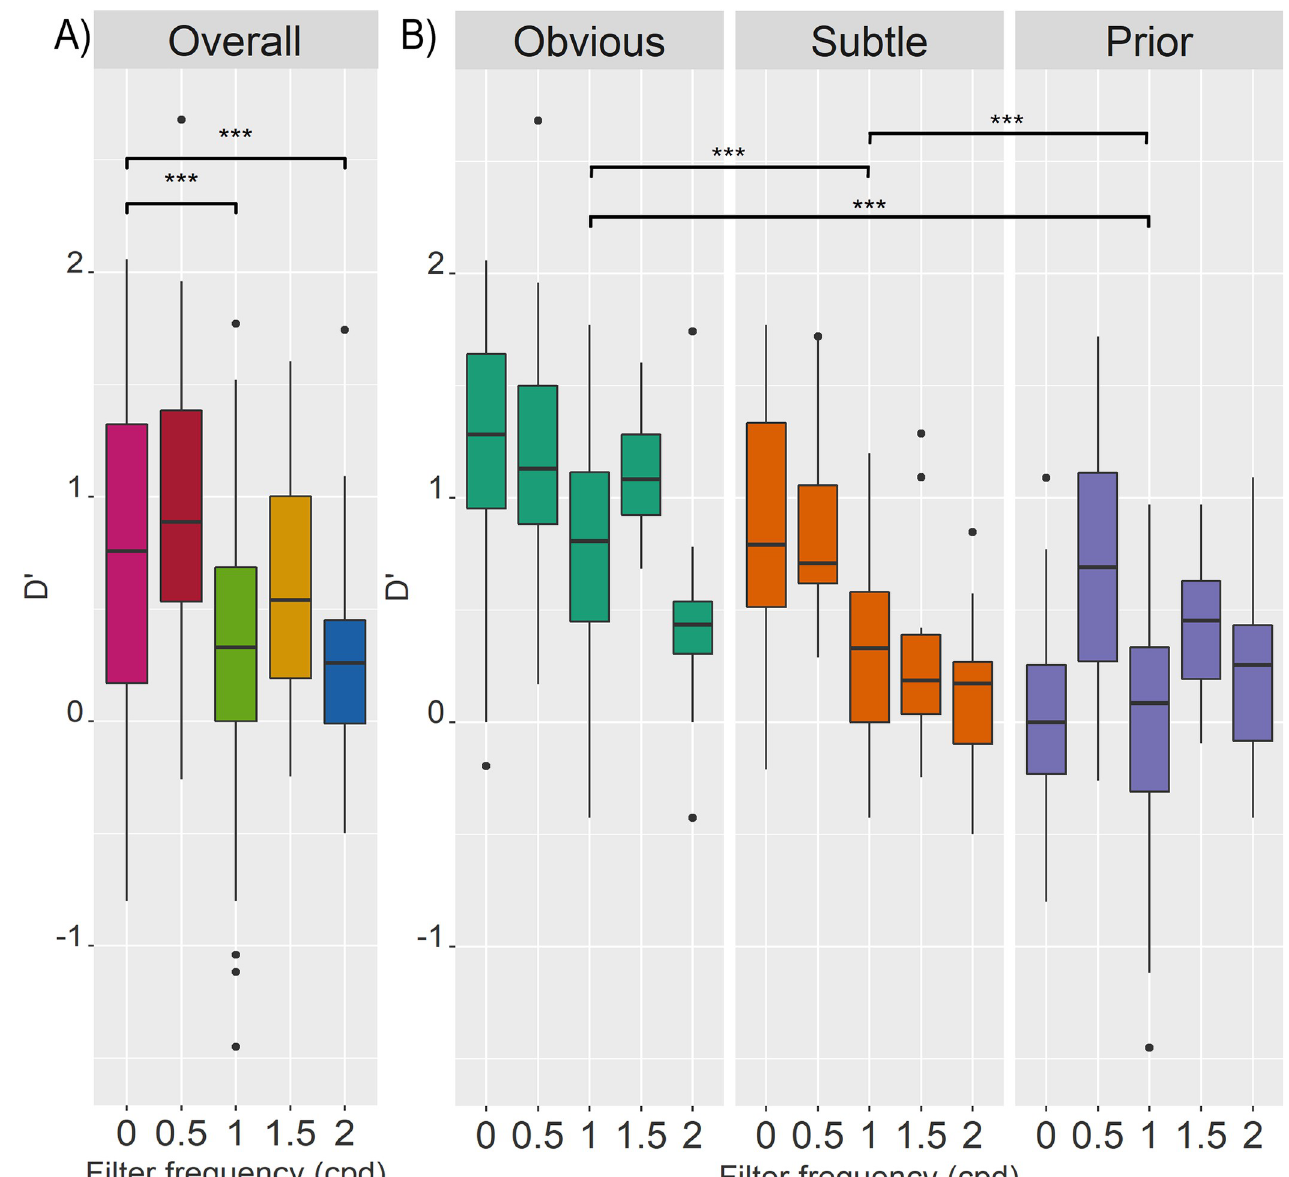
Fig 3. Boxplots of D’ across conditions. Each boxplot shows the median as the line within the coloured box containing the 25 th and 75 th percentiles, with extending whiskers containing the 95% CI, with any outliers plotted as dots. Significance of pairwise comparisons is indicated in the figure with � = p < .05, �� = p < .01, ��� = p < .001. (A) Boxplots showing D’ across frequency conditions (0, 0.5, 1, 1.5, and 2 cpd). Pairwise comparisons of frequency showed that D’ was significantly higher for F0 than F1 (estimated difference = 0.482, t(271) = 6.080, p = < .0001) and F2 (estimated difference = 0.397, t(282) = 4.502, p = < .0001), but did not differ significantly from F0.5 (estimated difference = -0.181, t(273) = -2.637, p = .067), and F1.5 (estimated difference = 0.007, t(282) = 0.083, p = 1.000)–and even trended towards a higher D’ in F0.5. (B) Boxplots showing D’ for each mammogram category (obvious, subtle, and prior) and frequency, to illustrate mammogram category and interaction effects. Pairwise comparisons of mammogram category showed that D’ was significantly higher for obvious than subtle (estimated difference = 0.462, t(258) = 7.278, p = < .0001) and prior mammograms (estimated difference = 0.683, t(258) = 10.763, p = < .0001), and higher for subtle than prior mammograms (estimated difference = 0.221, t(258) = 3.485, p = <